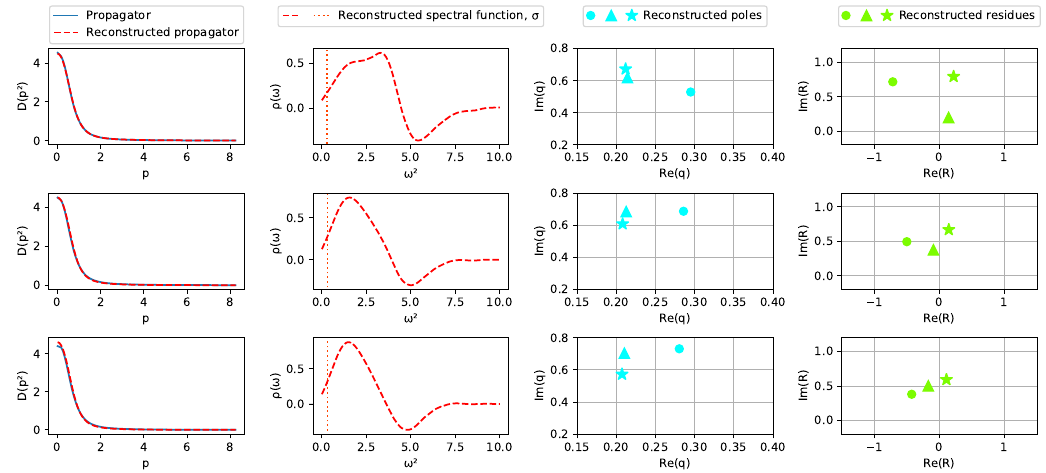
Figure 4: A selection of reconstructed spectral functions from 20,000 gluon propa- gators generated from Monte Carlo sampling (64 4 configuration), sorted according to their MAE: the best (top row), the median, and the worst (bottom